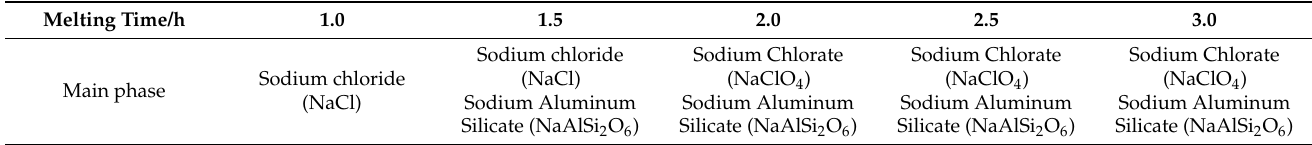
Figure 12. The XRD spectra of slag at different smelting time.